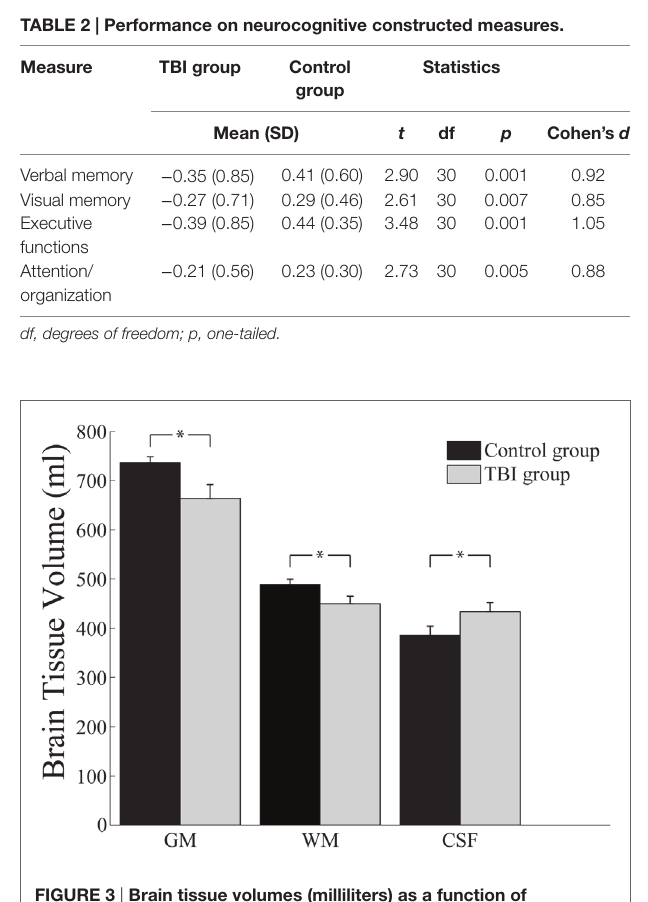
FigUre 3 | Brain tissue volumes (milliliters) as a function of participant group and brain tissue type . GM, grey matter. WM, white matter. CSF, cerebrospinal fluid; * p = 0.05.